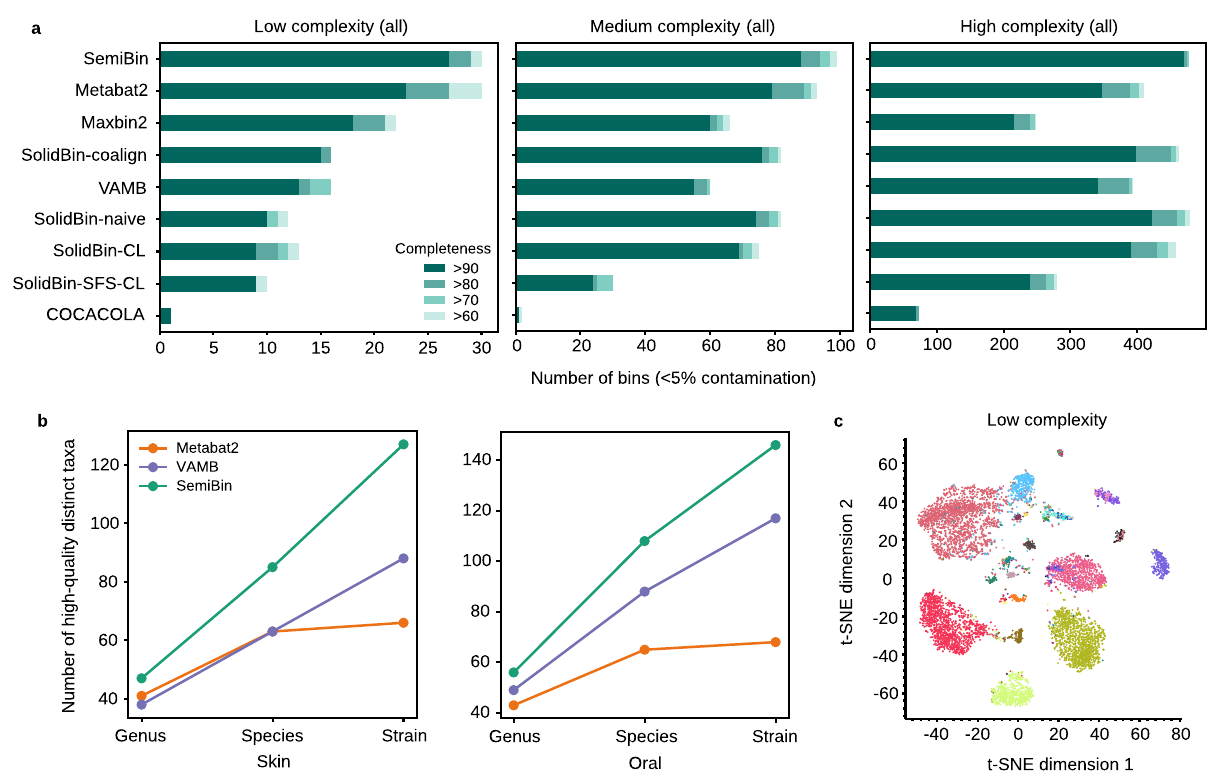
Fig. 2 SemiBin outperformed other binners in simulated datasets with single-sample, co-assembly, and multi-sample binning. a In CAMI I simulated datasets, SemiBin returned more high-quality bins. Shown are the numbers of reconstructed genomes per method with varying completeness and contamination <5% (methods shown, top to bottom: SemiBin, Metabat2, Maxbin2, SolidBin-coalign, VAMB, SolidBin-naive, SolidBin-CL, SolidBin-SFS-CL, and COCACOLA). b SemiBin reconstructed a larger number of distinct high-quality genera, species, and strains in the CAMI II Skin and Oral datasets compared to either Metabat2 or VAMB. A high-quality strain is considered to have been reconstructed if any bin contains the strain with completeness >90% and contamination <5% (see Methods). If at least one high-quality strain is reconstructed for a particular genus or species, then those are considered to have been reconstructed. c Semi-supervised embedding separates contigs from different genomes. Shown is a two-dimensional visualization of embedding of the low complexity dataset from CAMI I, with contigs colored by their original genome (using t-SNE, as implemented in scikit-learn, parameters: perplexity = 50, init = "pca" 77 ). Source data are provided as a Source Data fi